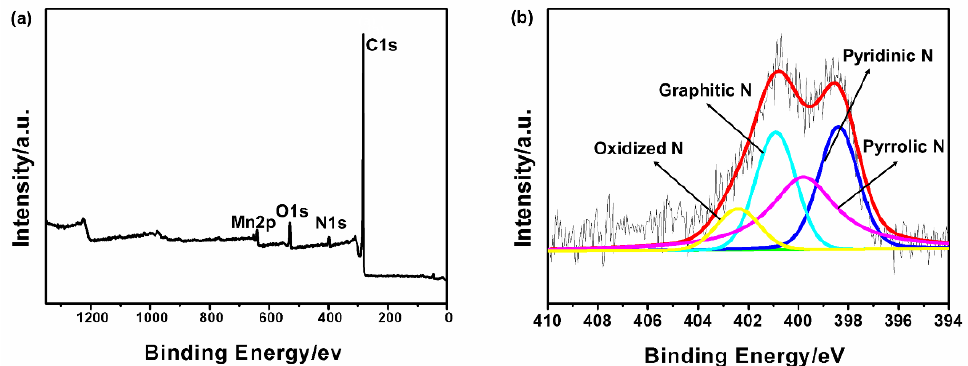
Figure 6. ( a ) XPS of MnO x @C-N; ( b ) N1s XPS spectra of MnO x @C-N.